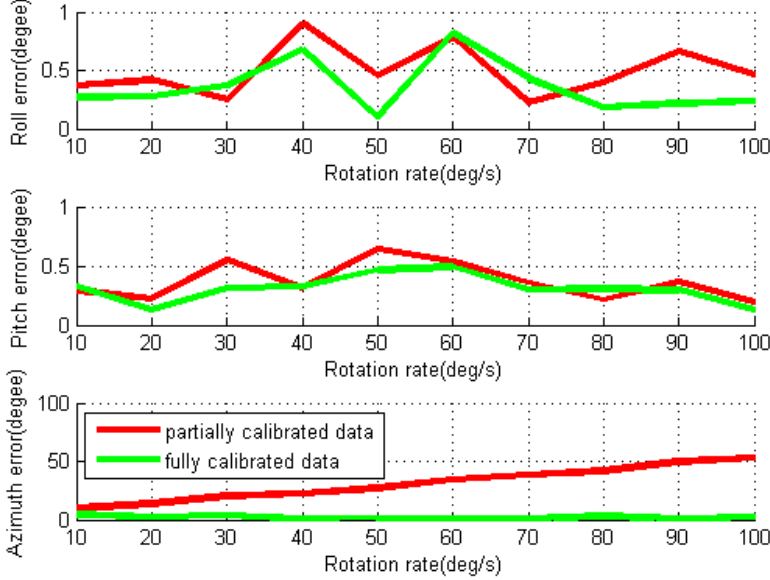
Figure 9. RMS values of attitude errors for rotary INS with different IMU rotation rates using MTi-G.